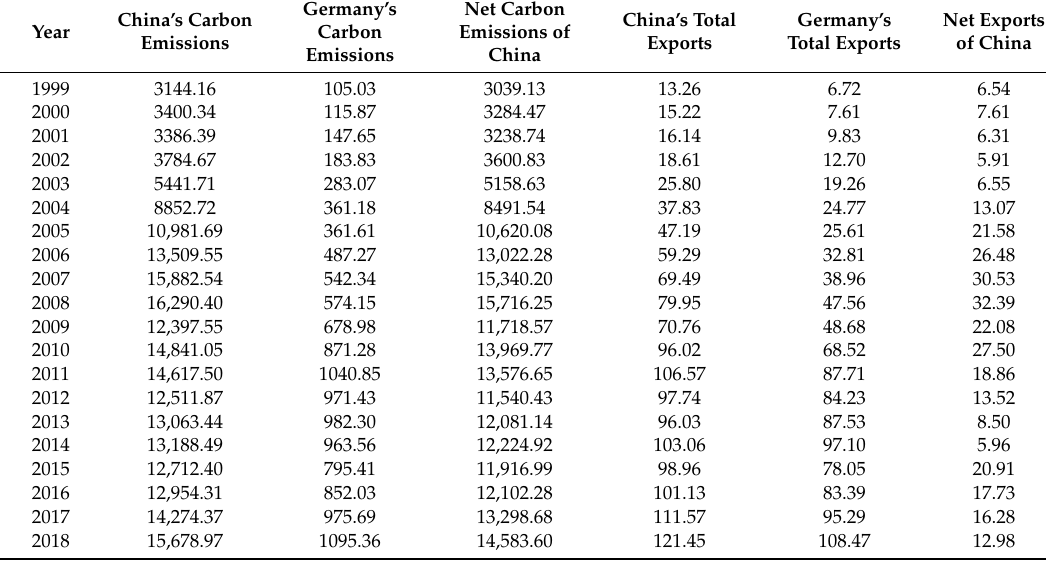
Table 6. The bilateral trades amounts and their embodied carbon emissions from 1999 to